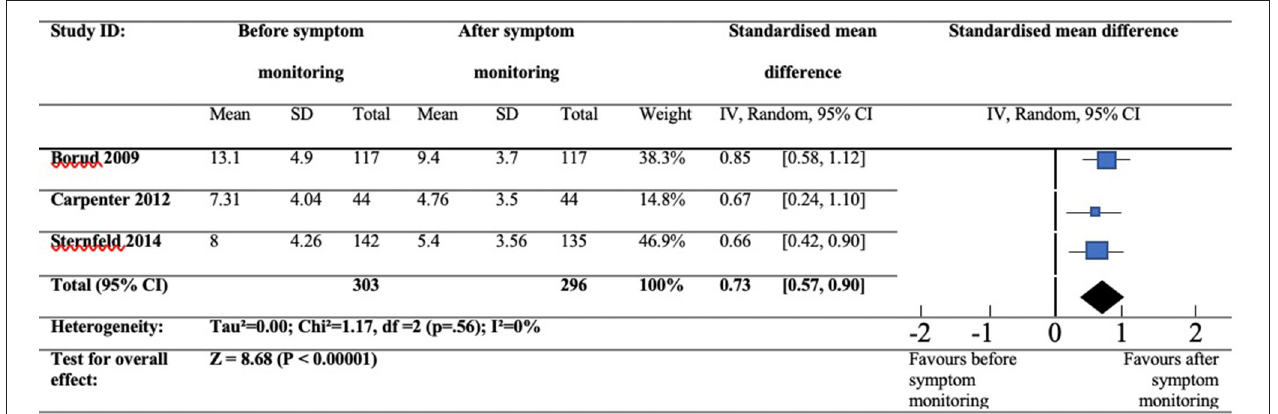
FIGURE 2 | F orest plot showing hot flush frequency at baseline and post-symptom diary